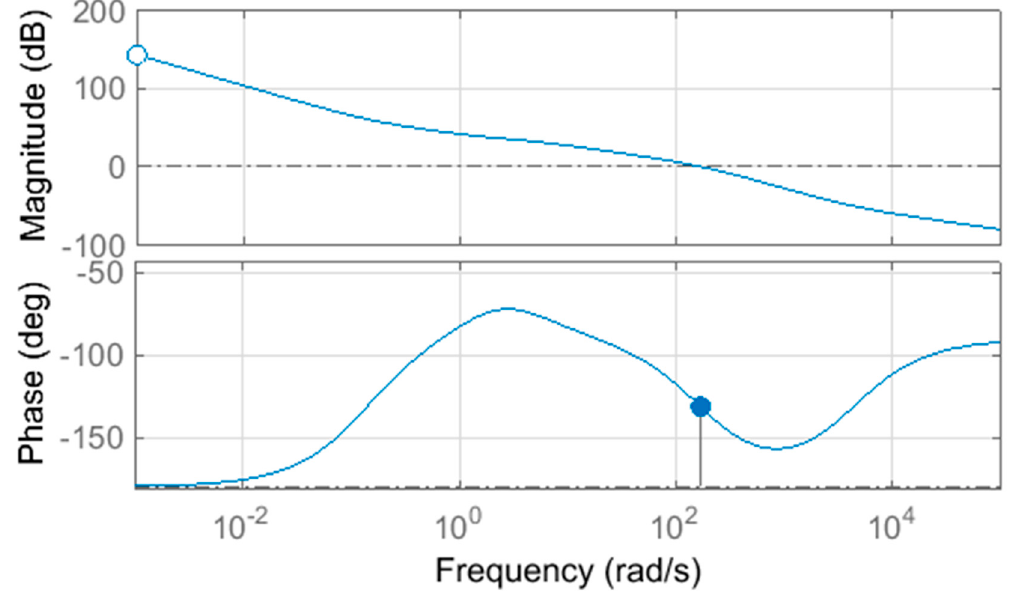
Figure 8. Bode diagram of closed-loop transfer function using PI controller ( K i = 0.09, and K p = 0.9).